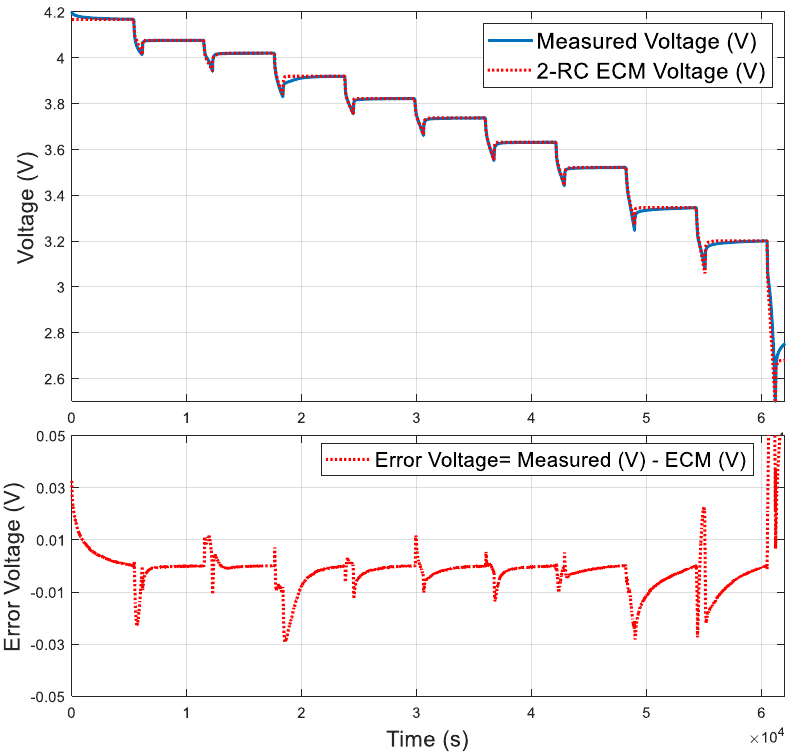
Figure 8. Derived parameter validation simulation results.